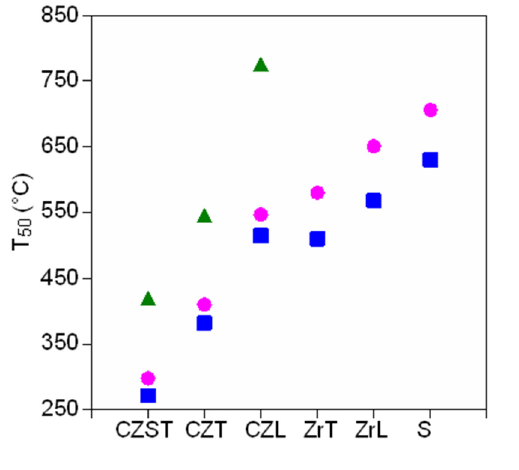
Figure 5. TGA results as T 50 for different contact and different atmosphere ( , air; , 1% O 2 /N 2 ; ▲ , N 2 ).